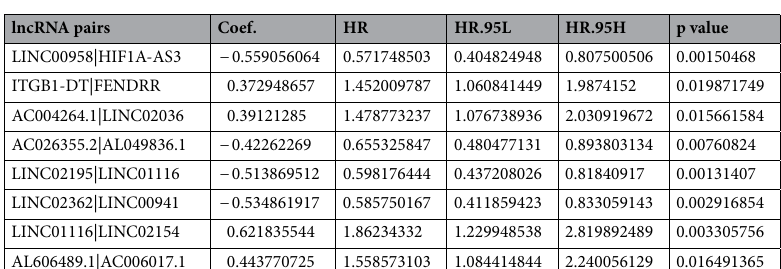
lncRNA pairs Coef. HR